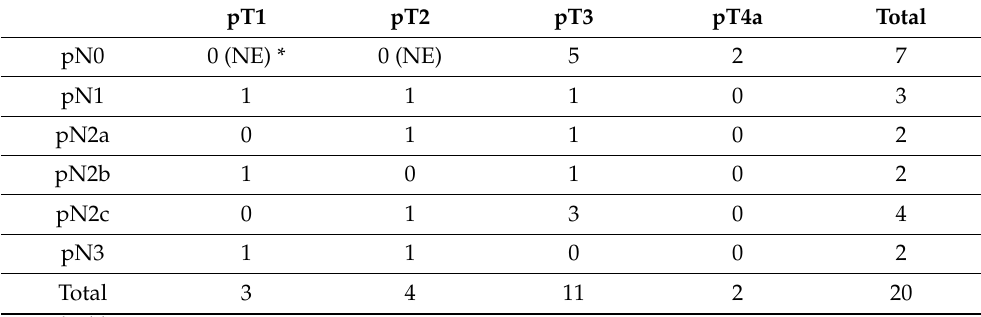
Table 1. Pathological tumor and nodal staging.